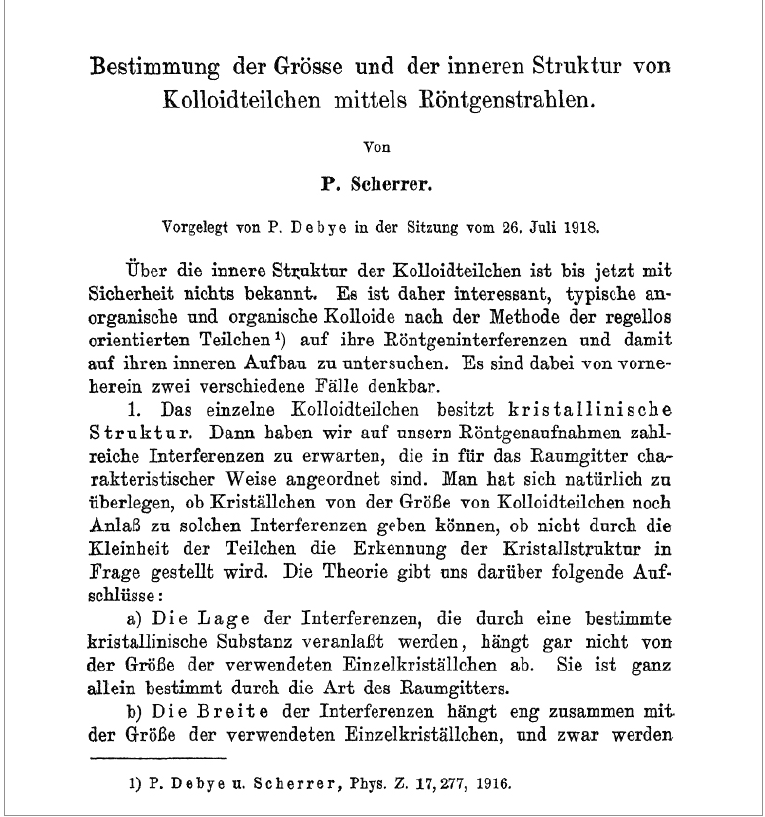
Figure 1: The first page of a digitised version of Scherrer’s article, showing Scherrer as the only